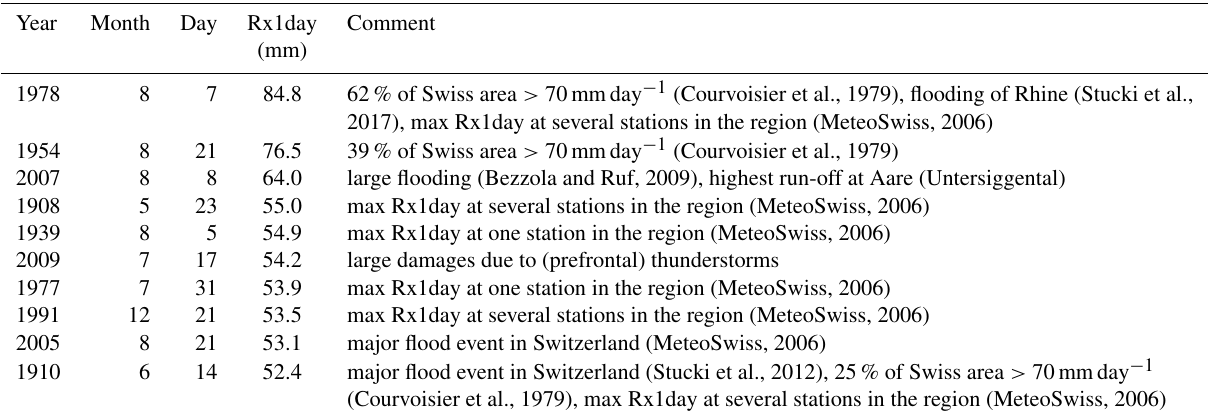
Table 2. The largest 10 Rx1day events in the catchment-averaged observations sorted by their